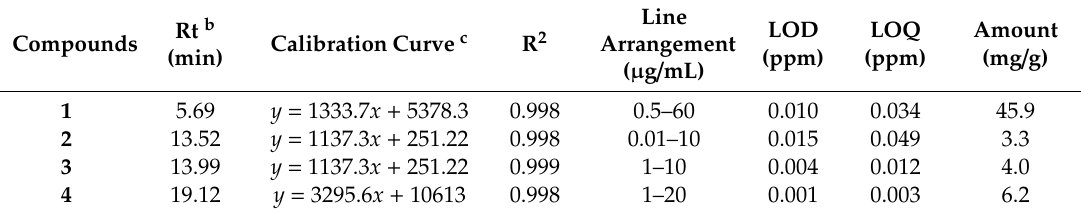
Table 1. Linear regression data and contents of the validated method for the investigated compounds (1–4) in EGB a . Rt b Calibration Curve c R 2 Compounds (min)